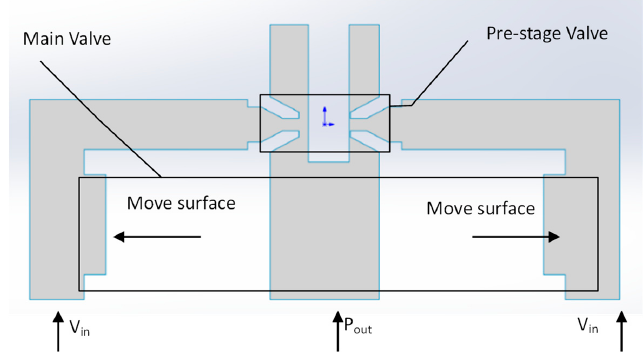
Figure 17. Watershed model of the servo valve considering the effect of the main valve.